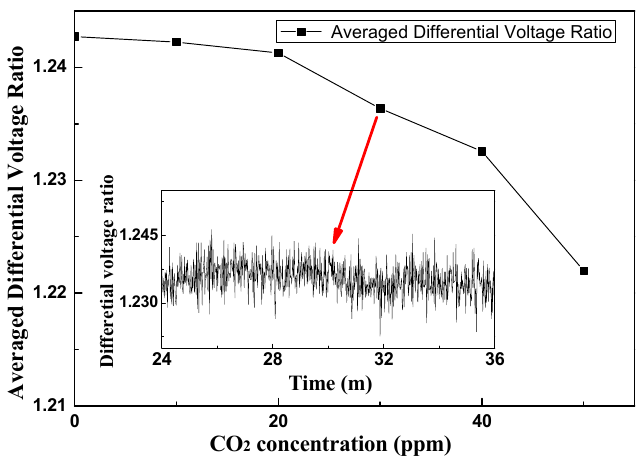
Figure 6. The measured averaged differential voltage ( ∆ U ) versus the CO 2 concentration within 0–50 ppm. The inset shows the recorded differential voltage ( ∆ U ) results of a 30 ppm sample for 10 min.